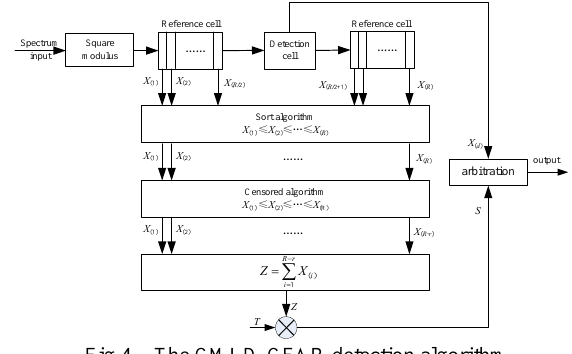
Fig.4 The CMLD-CFAR detection